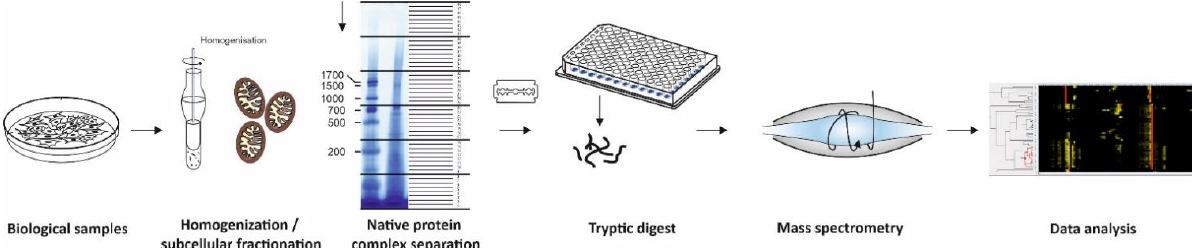
Figure 1. Workflow of complexome profiling. Sample preparation of biological samples include homogenization, subcellular fractionation, mild solubilization, and separation of native protein complexes by BNE or density gradients. Even fractions are placed into microtiter plates and digested with trypsin. Peptides are analyzed by quantitative mass spectrometry using LC- MSMS to gain information on peptide sequence. Data analyses comprise peptide and protein identification and quantification, hierarchical clustering of proteins with similar migration in the gels or gradients. These abundance profiles contain comprehensive information on protein complexes, subcomplexes, and super-assemblies.